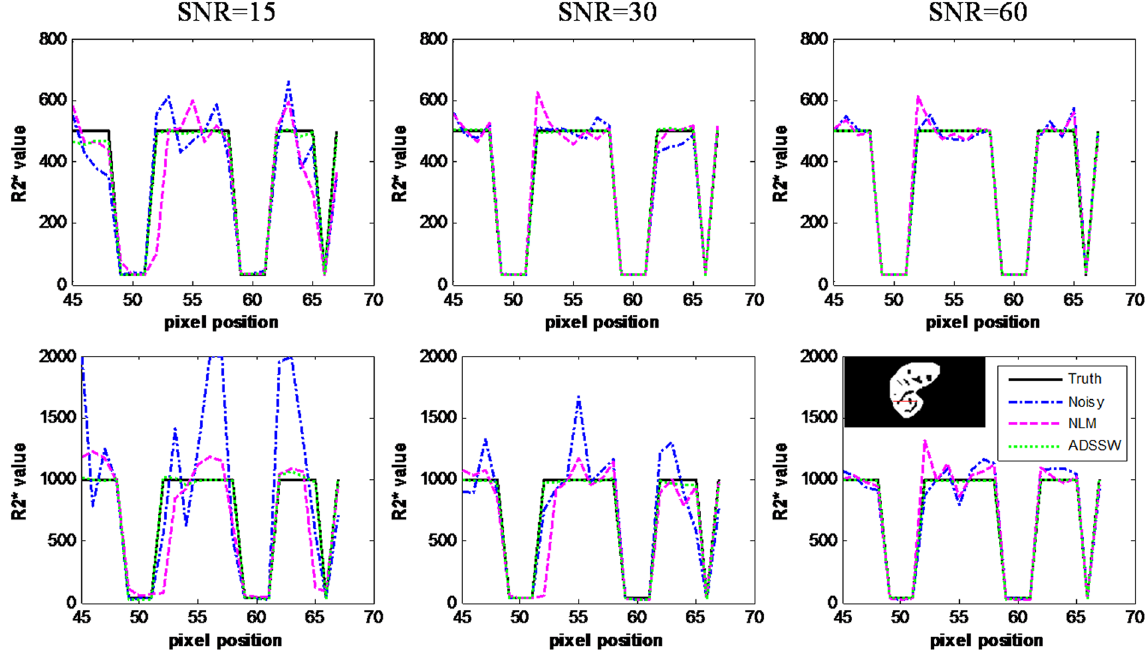
Figure 2. Plot of R2 * values across a line in the R2 * mapping fitted from NLM-, and ADSSW-filtered data, the true and the noisy R2 * mapping in the simulation study. Top row: true R2 * = 500 s − 1 . Bottom row: true R2 * = 1000 s − 1 . Left to right: SNR = 15, 30 and 60.